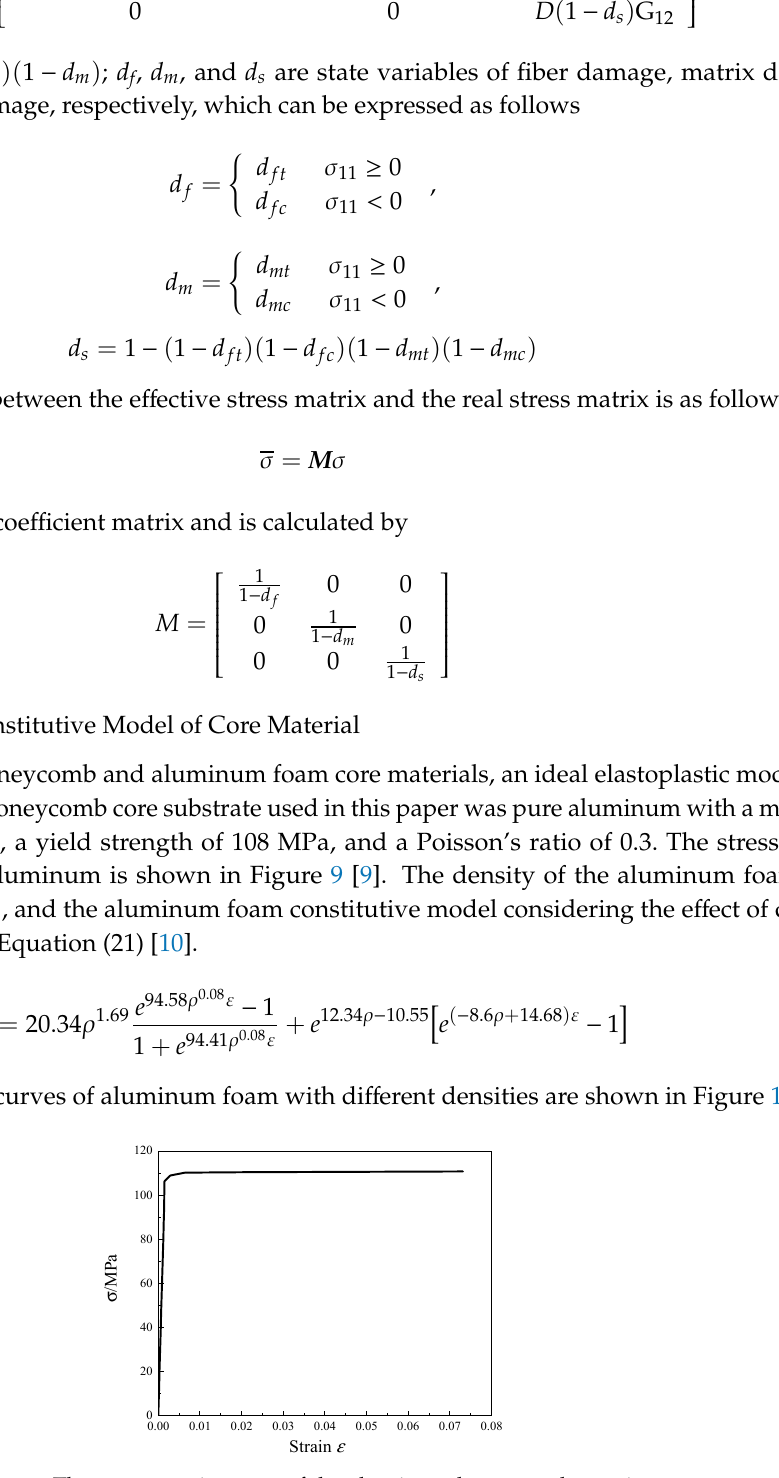
Figure 10. The stress–strain curves of aluminum foam with different densities. 3.1.3. Adhesive Interface Element Damage Analysis Model